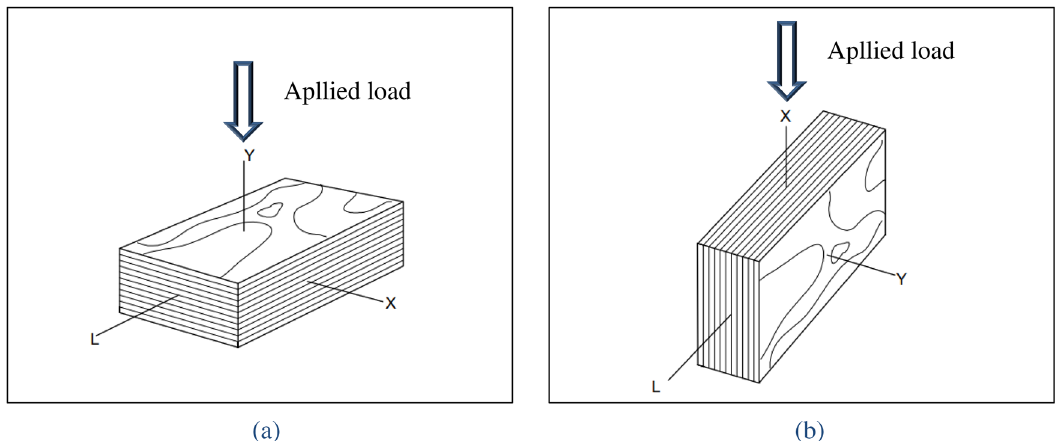
Figure 1: LVL sample con fi gurations: fl at ( a ) and edge ( b )